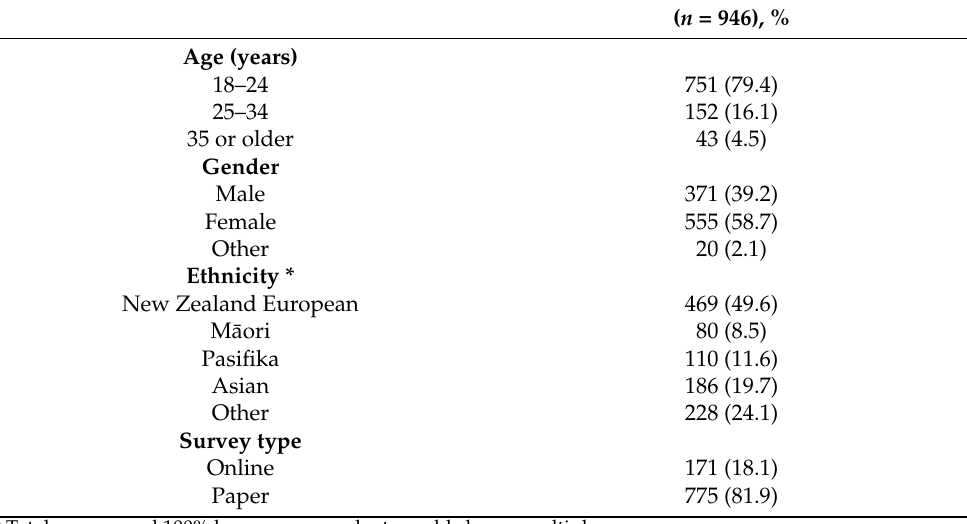
Table 1. Demographic characteristics of participants.